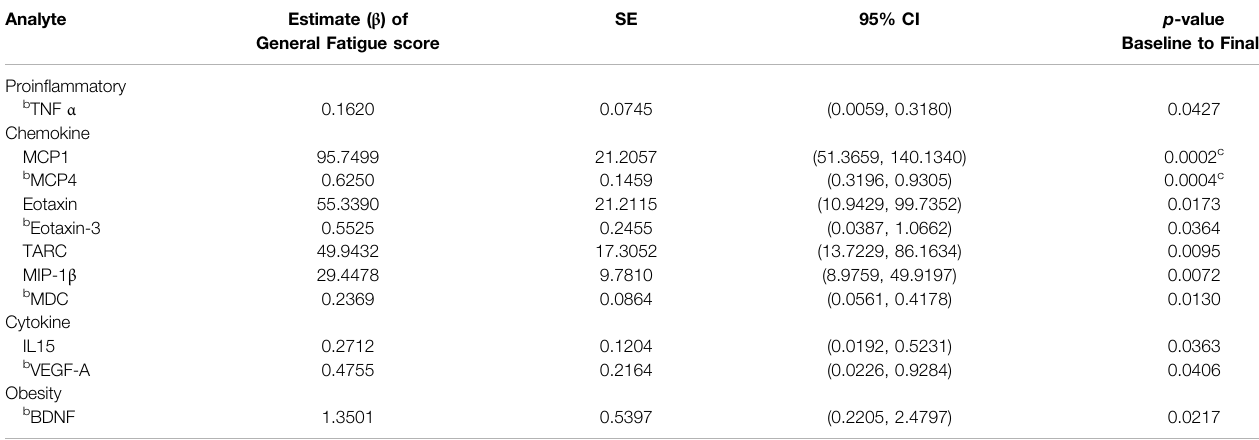
TABLE 7 | Association between mean change in serum analytes with General Fatigue Scores. General Linear Modelling (GLM) identi fi ed 11 blood serum analytes that were associated with increased levels of General Fatigue. Estimate β of the General Fatigue Score (column 2) utilizes participants who did not report an increase of General Fatigue between baseline and the study endpoint as the reference